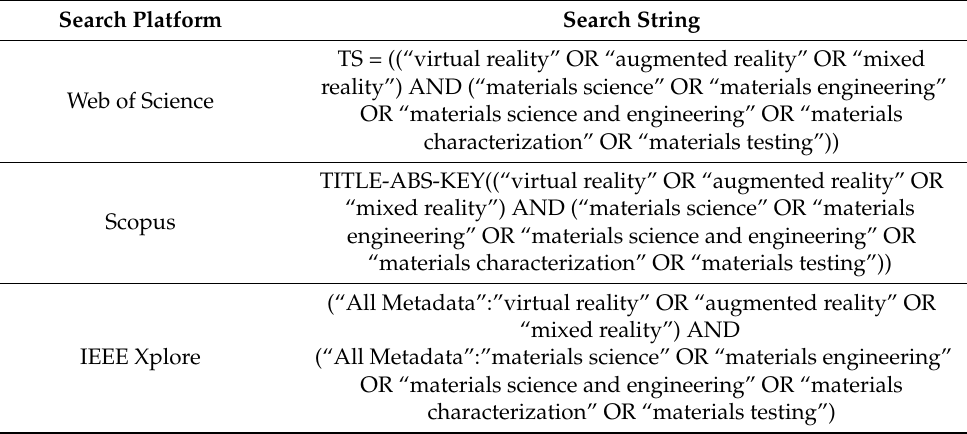
Table 3. Search string used on each search web